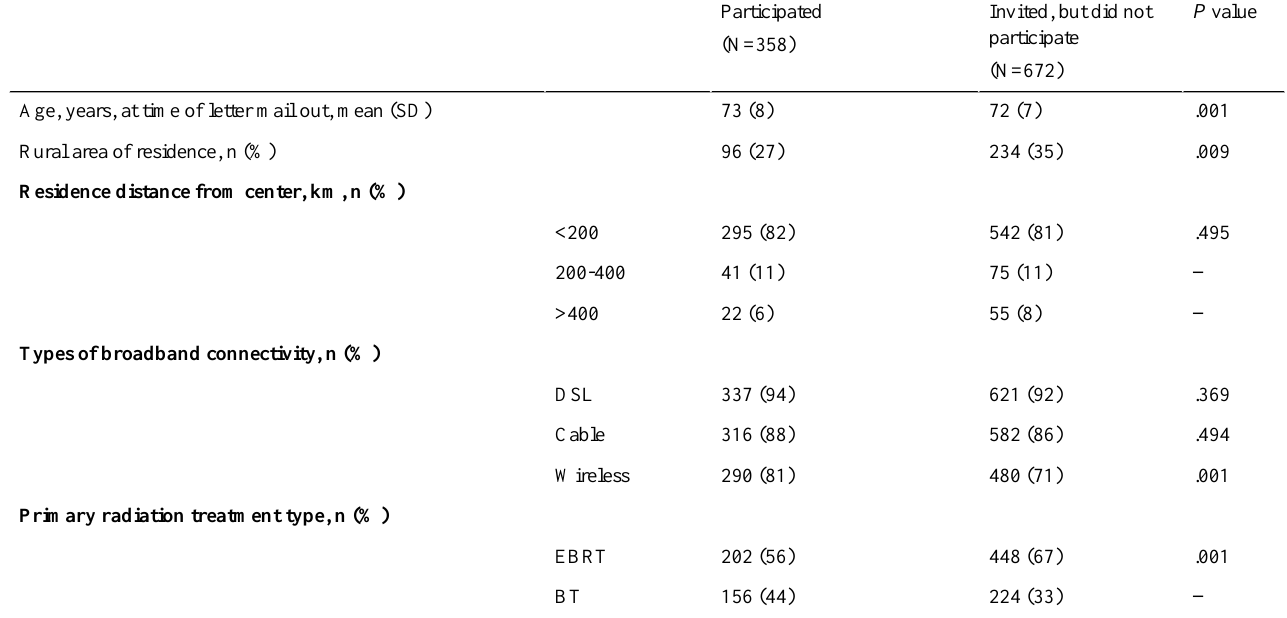
Table 1. Demographic factors of participants and